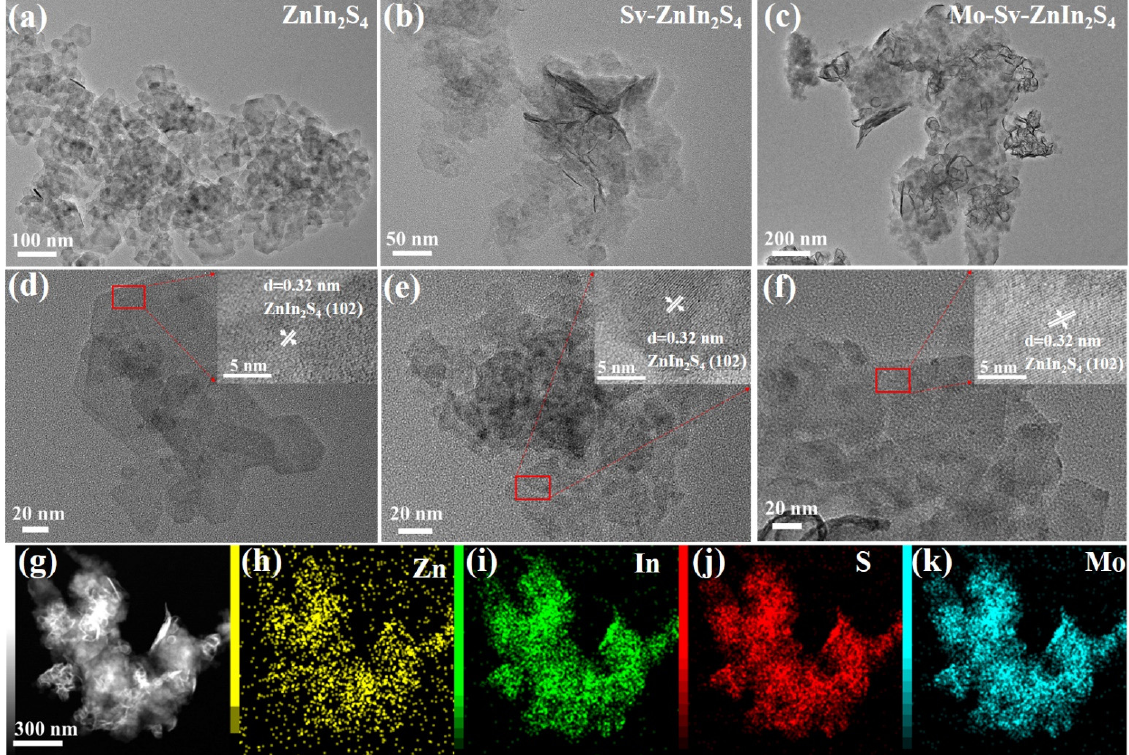
Figure 2. ( a , d ) TEM ( a ) and HRTEM ( d ) images of the ZIS. ( b , e ) TEM ( b ) and HRTEM ( e ) images of the Sv-ZIS. ( c , f ) TEM ( c ) and HRTEM ( f ) images of the 1.5% Mo-Sv-ZIS. ( g ) HAADF-STEM image of the 1.5% Mo-Sv-ZIS. ( h – k ) EDS element mappings of Zn ( h ), In ( i ), S ( j ) and Mo ( k ) in 1.5% Mo- Sv-ZIS. (Note: The area inside the red square is the area magnified by HRTEM) ZIS, Sv-ZIS and Mo-Sv-ZIS are investigated further by XPS for chemical states and apparent chemical compositions. Figure S3 displays the full spectrum of ZIS, Sv-ZIS and Mo-Sv-ZIS containing the typical peaks of Zn 2 p , In 3 d , S 2 p and Mo 3 d , which is consistent with the EDS’ results. Figure 3a shows that the Zn 2 p characteristic peaks of ZIS are located at 1022.05 eV and 1045.06 eV, which belong to 2 p 3/2 and 2 p 1/2 , respectively. In comparison, the Zn 2 p XPS peak positions of Sv-ZIS undergo negative shifts of 0.28 eV and 0.26 eV, separately indicating a decrease in the coordination number of Zn atoms due to the pres- ence of sulfur vacancies [5]. The doping of Mo shifted the peak positions of Mo-Sv-ZIS positively by 0.1 eV and 0.08 eV, which means that the Zn atoms returned to the higher binding energy region after the doping of Mo. As shown in Figure 3b, the In 3 d character- istic peaks of ZIS are located at 445.14 eV and 452.68 eV, which are assigned to In 3 d 5/2 and 3 d 3/2 , respectively. The In 3 d peaks of Mo-Sv-ZIS and Sv-ZIS are essentially the same, with negative shifts of 0.19 eV and 0.15 eV, respectively. After the addition of Mo, the XPS peak position of In is almost unchanged, while the binding energy of Zn varies more than that of In, indicating that Mo replaces the position of Zn rather than that of In. The radius of Zn atom is 1.39 Å, and the radius of Mo atom is 1.40 Å, which are very close. Therefore, it is feasible to replace the Zn atom with the Mo atom. As shown in Figure 3c, the S 2 p char- acteristic peaks of ZIS are located at 161.88 eV and 163.18 eV, which belong to 2 p 3/2 and 2 p 1/2 , respectively. On the other hand, the S 2 p XPS bands of Sv-ZIS underwent negative shifts of 0.09 eV and 0.18 eV, respectively, proving the existence of S vacancies in ZIS. After doping with Mo atoms, S 2 p 3/2 and S 2 p 1/2 negatively shift to 0.13 eV and 0.14 eV,